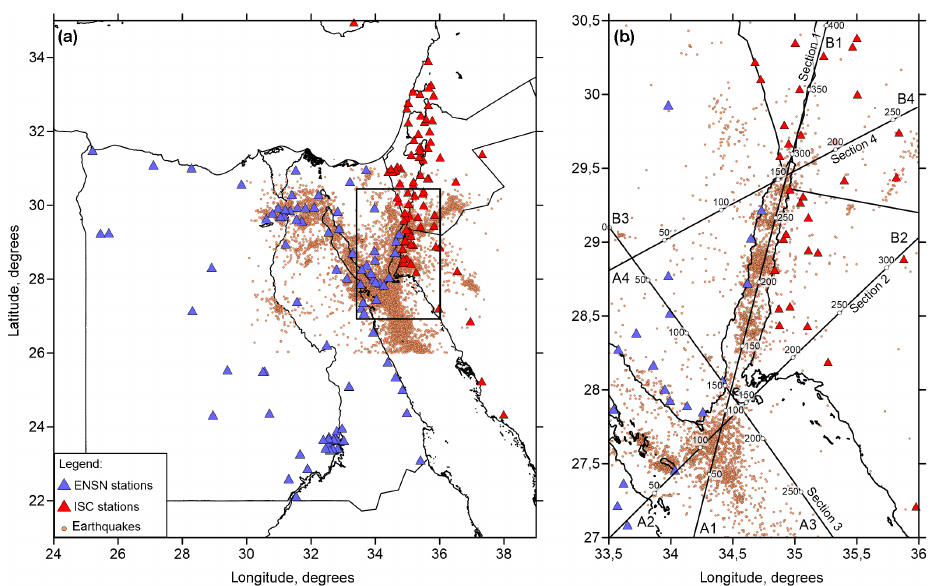
Figure 2. Distributions of seismic stations from the ENSN catalog and ISC catalog. (a) Map of the entire network at the regional scale. (b) Stations and events within the study area. Orange dots represent the following types of seismicity: all events collected from the ENSN catalog (a) and selected relocated events used in this study (b) . Locations of the profiles, for which the vertical sections will be presented, are shown in (b)